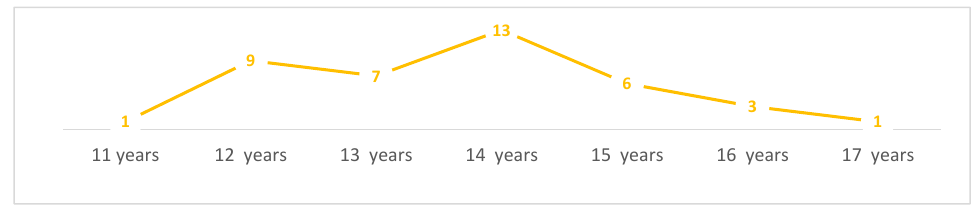
Figure 1. The ages of the participants.